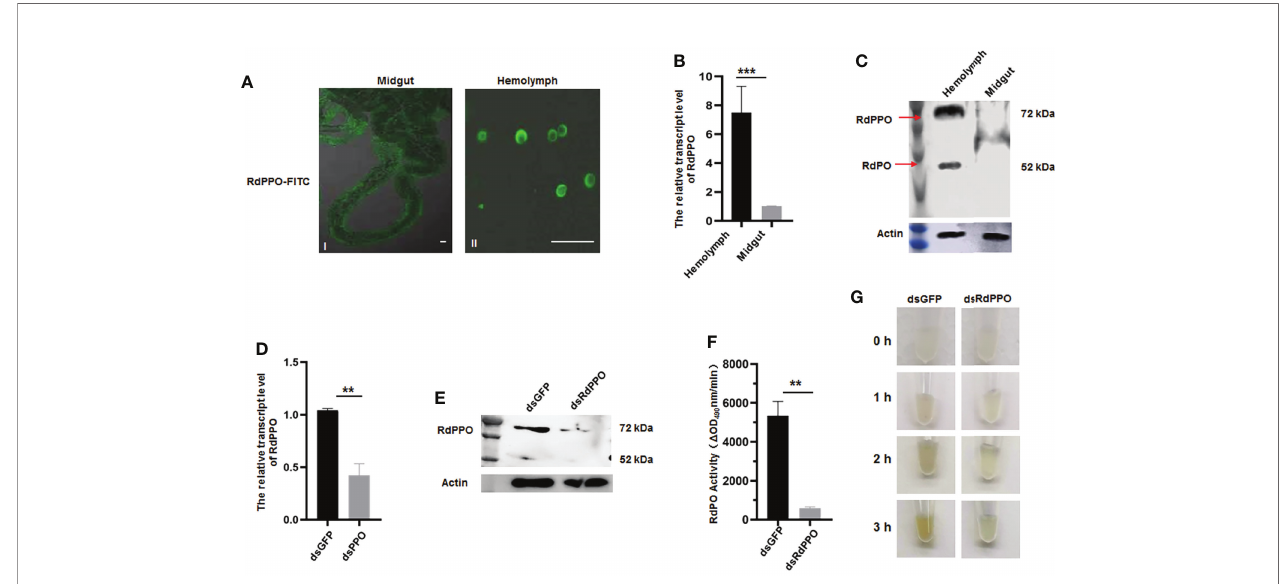
FIGURE 2 | The role of RdPPO in the melanization reaction of nonviruliferous R. dorsalis. (A) Distribution of RdPPO in the midgut and hemolymph of nonviruliferous R. dorsalis . Leafhopper organs and tissues were dissected and analyzed by immuno fl uorescence assay. The alimentary canals and hemolymph were immunolabeled with RdPPO-speci fi c antibody conjugated to FITC and examined by confocal microscopy. (B) Transcript levels of RdPPO in the midgut and hemolymph of healthy leafhoppers were normalized to the transcript levels of the internal control Actin gene. (C) RdPPO protein levels in the midgut and hemolymph of healthy leafhoppers. Total proteins were extracted from the dissected midguts or hemolymph of healthy leafhoppers and subjected to immunoblotting with RdPPO-speci fi c antibody. The bands containing RdPPO and RdPO are labeled with red arrows. Leafhopper Actin was used as an internal control. (D) Transcript levels of RdPPO genes in R. dorsalis after microinjection with dsRNAs (dsGFP or dsRdPPO), as detected by RT-qPCR. The transcript levels of PPO were normalized to the transcript levels of the internal control Actin gene in whole bodies of nonviruliferous R. dorsalis at 7 d post-microinjection of dsPPO and dsGFP. P-values were estimated using Student ’ s t- test. (E) PPO levels in R. dorsalis after treatment with dsGFP or dsRdPPO. At 7 d post-microinjection, total protein were extracted from 15 nonviruliferous R. dorsalis injected with dsGFP or dsRdPPO and subjected to immunoblotting with RdPPO-speci fi c antibody. The bands containing RdPPO and RdPO are labeled with red arrows. Leafhopper Actin was used as an internal control. (F) PO activity in the hemolymph of Recilia dorsalis injected with dsGFP or dsRdPPO. Hemolymph samples were collected at 5 d after treatment and subjected to activity assays. Each value is given as the mean ± SEM of three replicates. Asterisks indicate differences (*, P < 0.05) between the indicated groups. (G) In vitro spontaneous melanization assay of the hemolymph from leafhoppers subjected to different treatments. Hemolymph was collected from R. dorsalis injected with dsGFP or dsRdPPO and subjected to a spontaneous melanization assay. The biosynthesis of melanin was recorded by photography at different time points from 0 to 3 (h) Scale bars, 20 m